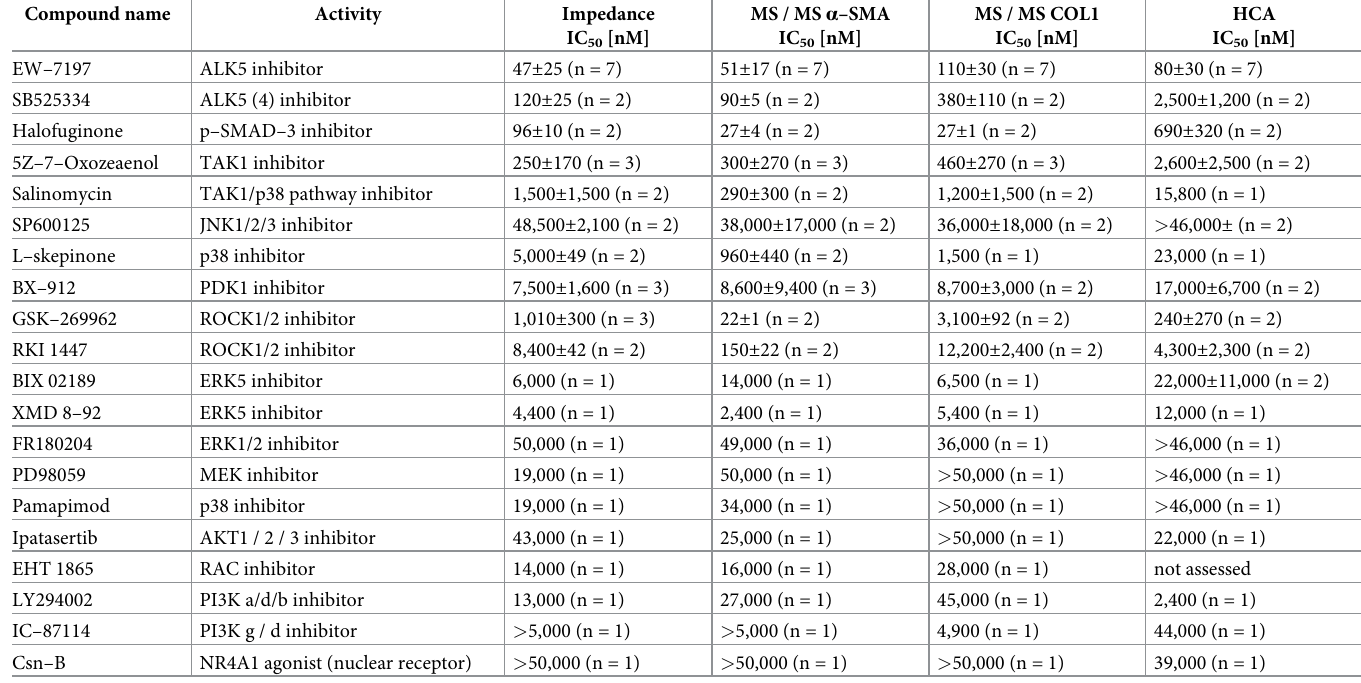
Table 1. IC 50 values for small molecule inhibitors of TGF– β 1 signaling.